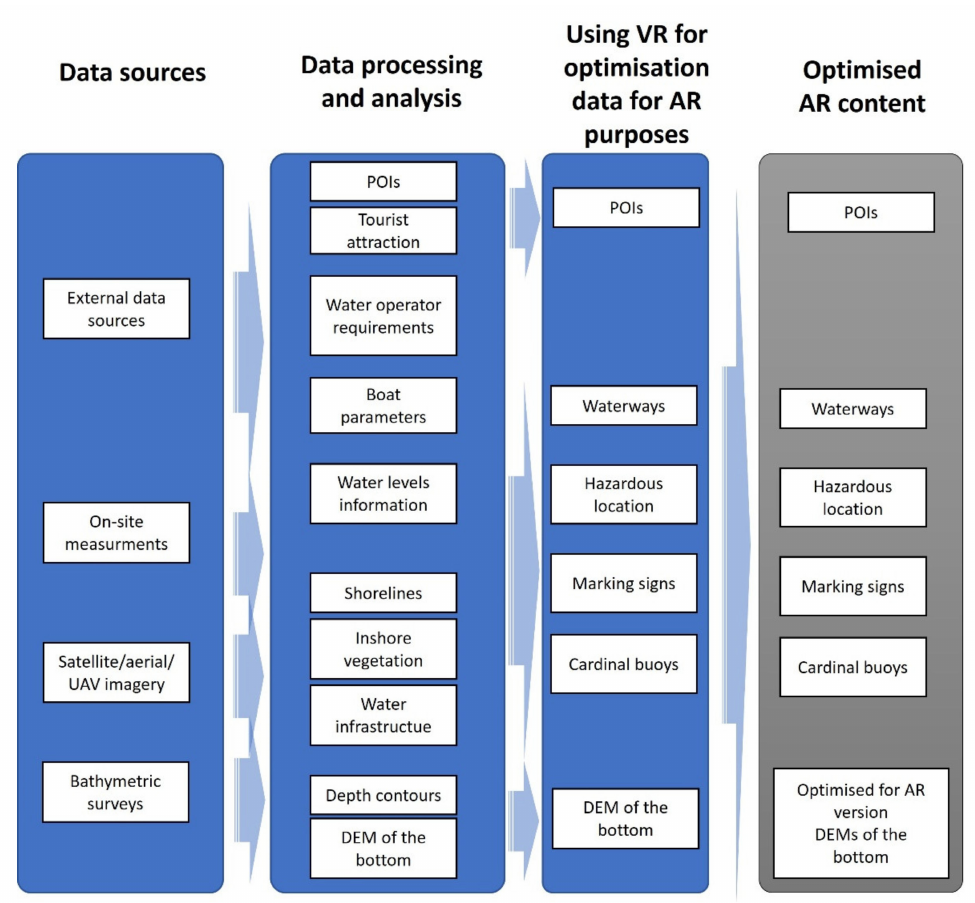
Figure 6. Data sources and processing methodology for preparing AR-optimised